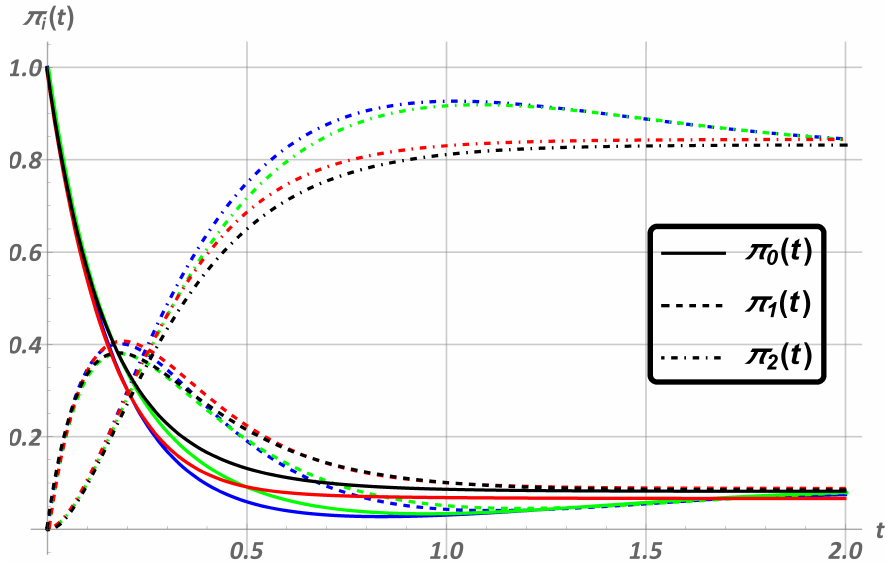
Figure 4. T.d.s.s.p.’s of (cid:104) M 2 < 6 | Erl | 1 (cid:105) ( b = 1, f = 2) with different values of coefficients of variation of components v b and system v f repair